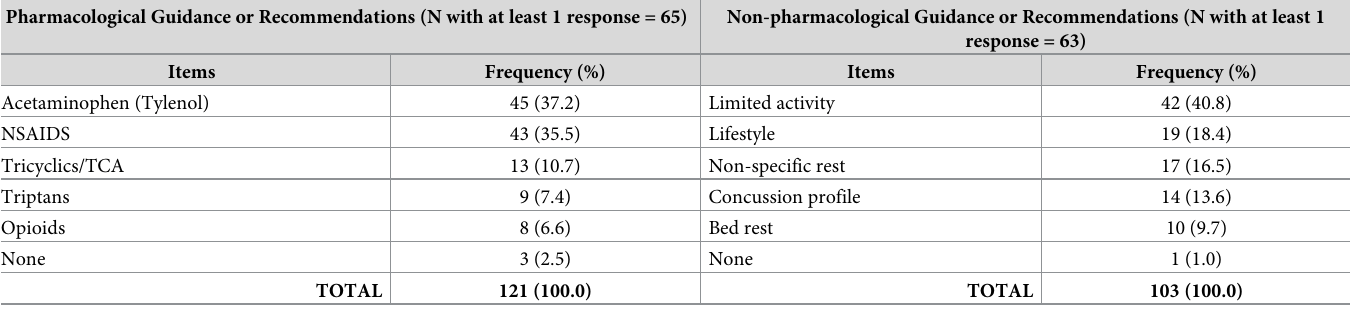
Table 2. Pharmacological and/or non-pharmacological guidance or recommendations to patient with sustained headache following concussion. Pharmacological Guidance or Recommendations (N with at least 1 response = 65)